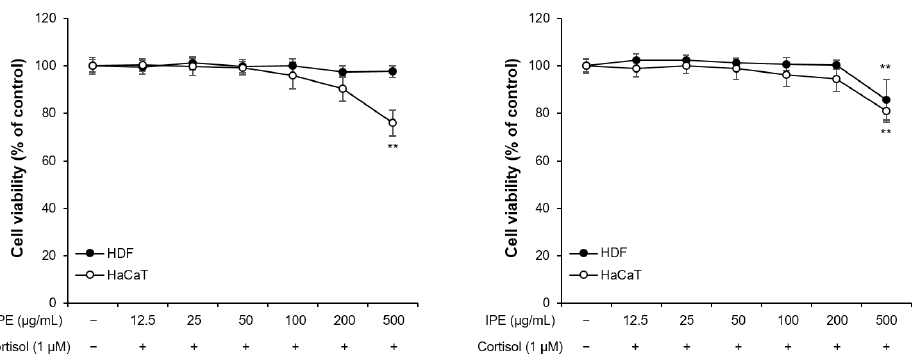
Figure 1. Effects of Iris pallida extract (IPE) on the viability of HDFs and HaCaT cells. The cells were treated with IPE at various concentrations (12.5, 25, 50, 100, 200, and 500 µ g/mL) for 48 h with or without cortisol (1 µ M). Cell viability was assessed using the cell counting kit (CCK)-8 assay. ** p < 0.01 compared to the